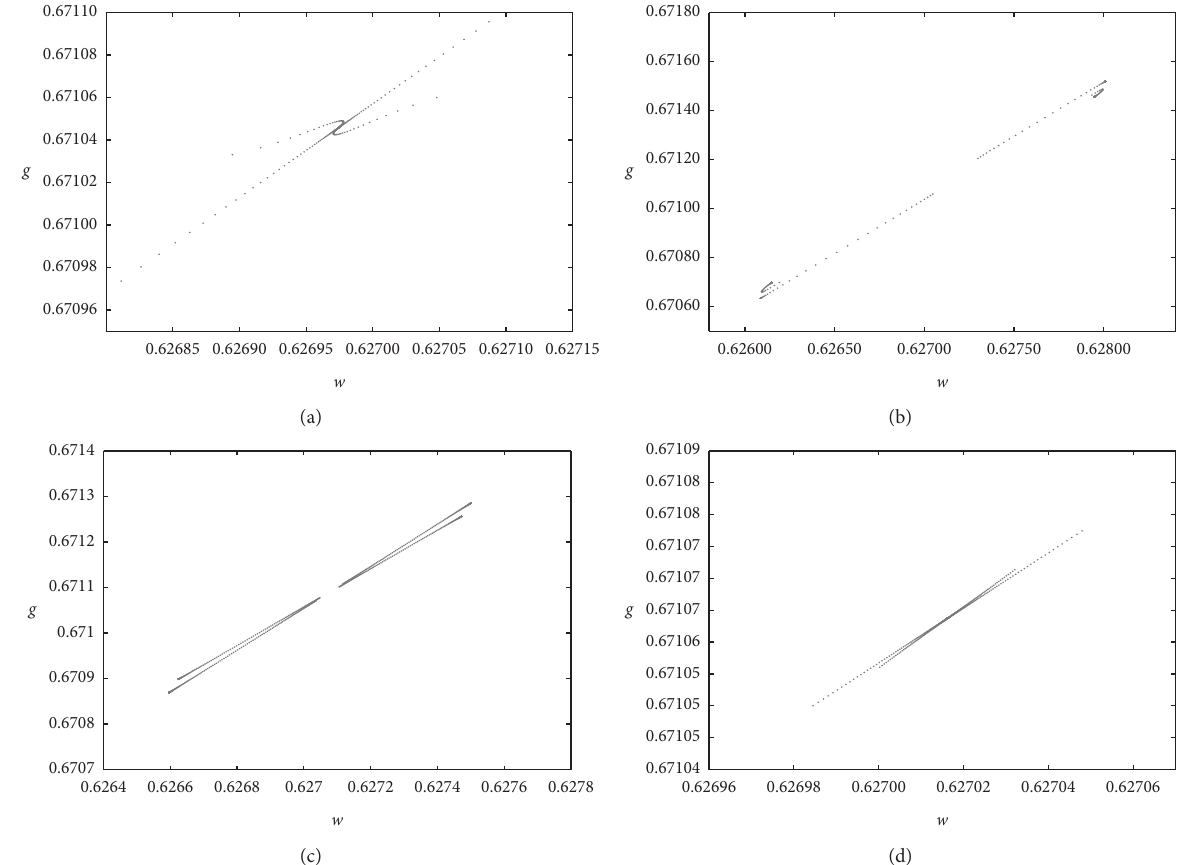
Figure 7: Phase portraits: (a) a � 267 . 2007 and b � 17 . 422455; (b) a � 267 . 2008 and b � 17 . 422455; (c) a � 267 . 20079 and b � 17 . 42246; (d) a � 267 . 20076 and b � 17 . 42246.